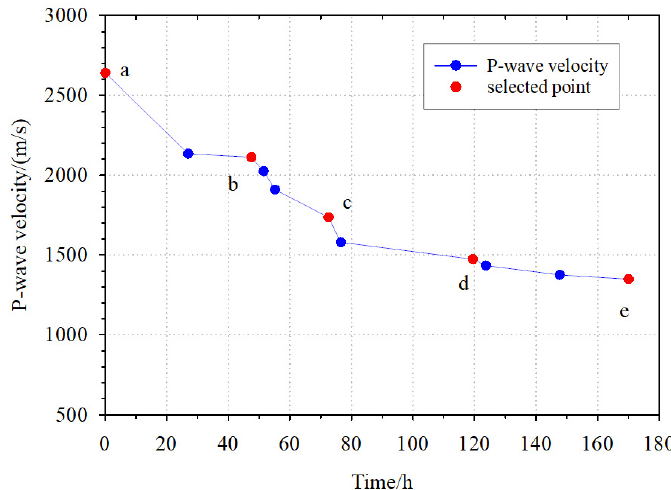
Figure 3. Variation in P-wave velocity during hydrate dissociation.